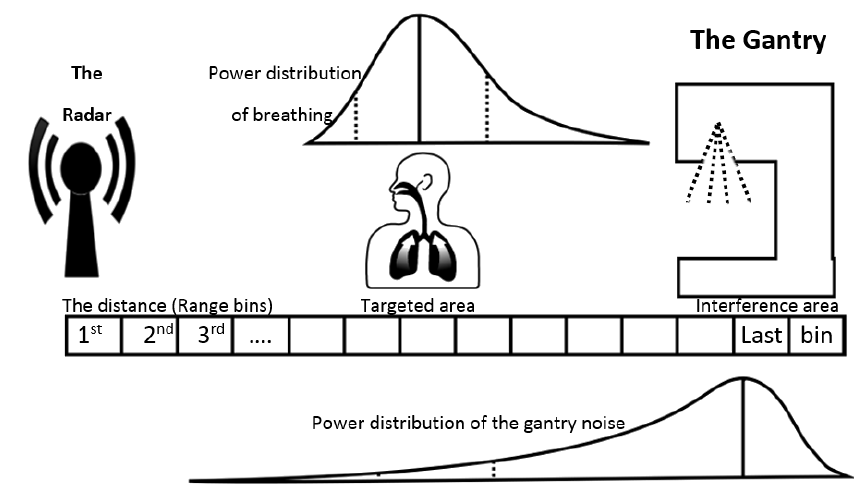
Figure 1. Schematic illustration of the experimental setup. The radar system was placed at the foot-end of the treatment couch facing the RMP and linac gantry. The power distributions of the RMP and gantry are broad and attributed to the relatively non-local nature of their motion.